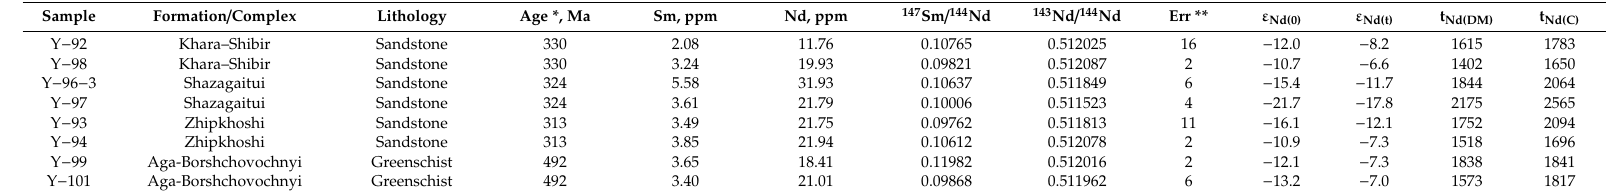
Table 2. Whole-rock Sm-Nd isotopic compositions of the rocks of Chiron